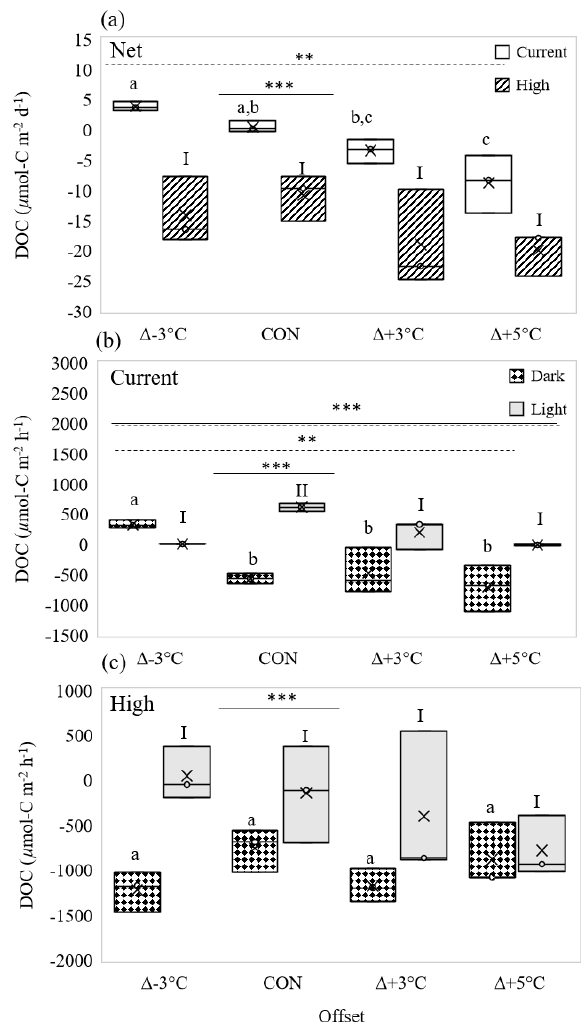
Figure 5. Effect of three temperature offsets from control (CON = 23 ◦ C) on (a) net dissolved organic carbon (DOC) fluxes (µmolCm − 2 d − 1 ) under current (open boxes) and high- p CO 2 con- ditions (hatched boxes). Light (grey boxes) and dark fluxes (spot- ted boxes) of DOC (µmolCm − 2 h − 1 ) for (b) current p CO 2 and (c) high- p CO 2 conditions. In panel (a) letters identify significantly different means across temperatures under current p CO 2 condi- tions, and numerals identify significantly different means across temperatures under high- p CO 2 conditions; in panels (b) and (c) letters identify significantly different means across temperatures in dark cycles, and numerals identify significantly different means across temperatures in light cycles. Letters or numerals that are the same indicate no significant difference, as determined by a one-way ANOVA and post hoc Tukey’s test. Solid and dashed horizontal lines identify significant effects of p CO 2 or light and temperature, respectively, where double solid and dashed lines identify signifi- cant interaction of temperature and light (two-way ANOVA). Lev- els of significance are denoted with “ ∗ ” for 0.05, “ ∗∗ ” for 0.01, and “ ∗∗∗ ” for 0.001. Data in Table